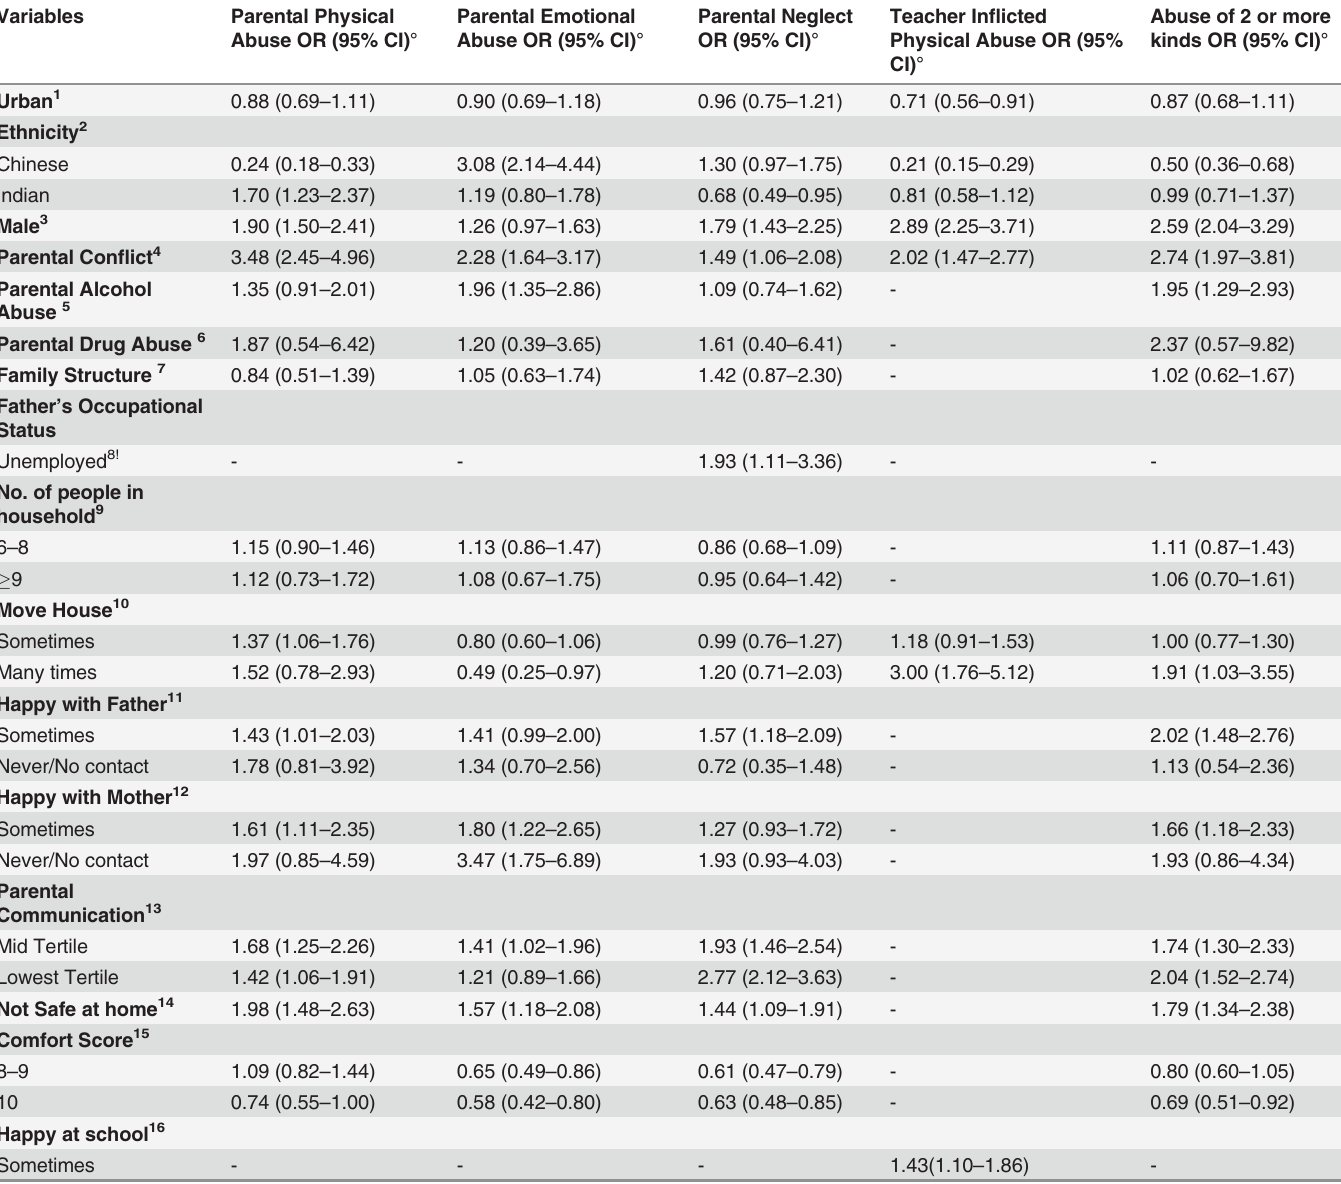
Table 2. Multivariate associations between demographic, parental & environmental factors and child